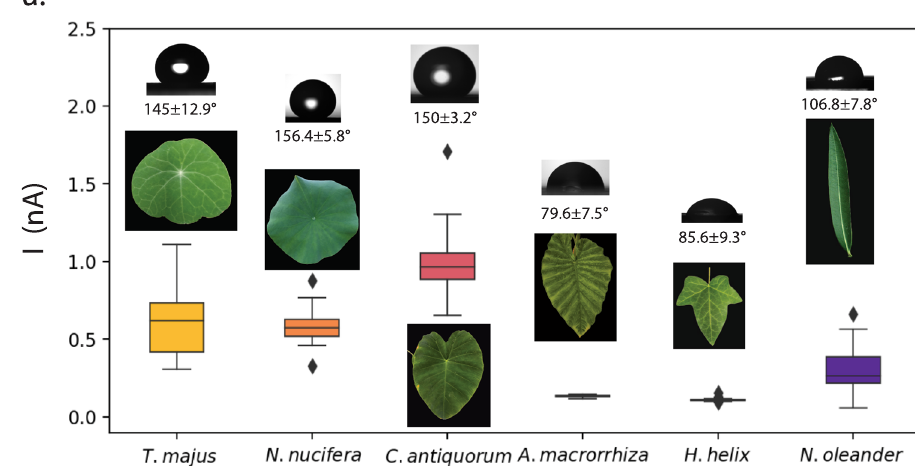
Fig. 7 Comparison of water droplet contact electri fi cation on different plant species. Boxplot summarizing currents measured in fresh leaves of N. nucifera , T. majus, C. antiquorum, H. helix, N. oleander and A. macrorrhiza upon impact of DI water droplets. The statistics for all experiments have been obtained from 50 measurements of 50 droplets per datapoint (except for T. majus 20 droplets) recorded after initially 3000 droplets have sequentially been dropped onto the leaf to assure stable signals. Leaf photographs and contact angle for each species are reported as insets. Leaf-droplet interactions of the different species are given in Supplementary Movies 2 and